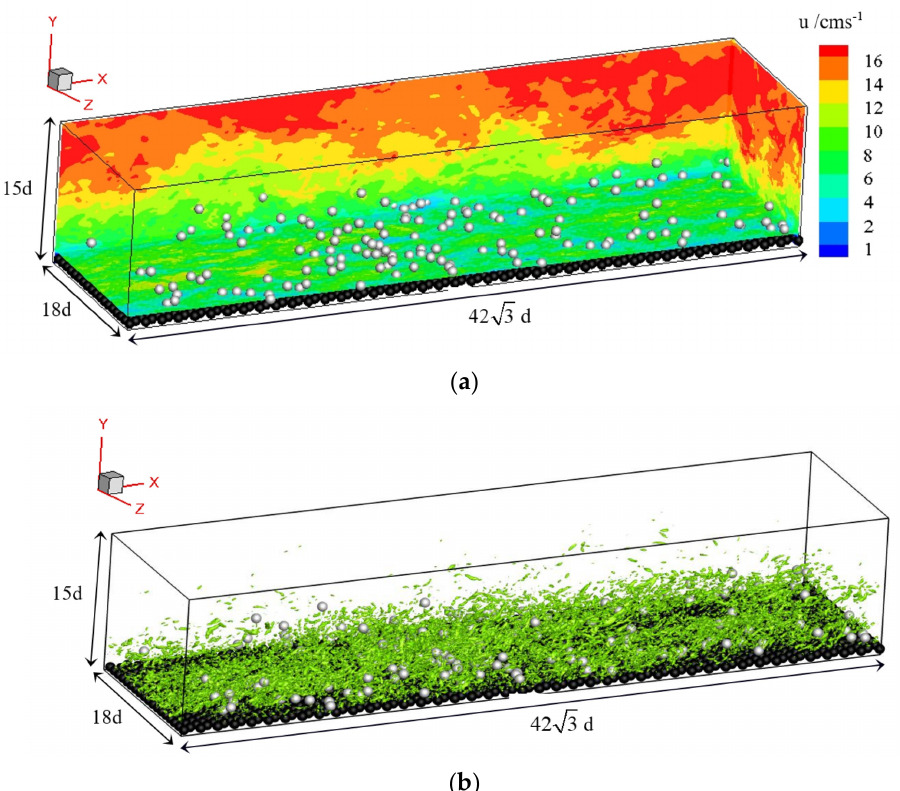
Figure 5. Instantaneous velocity and vorticity fields of the flow and particle distribution. The black particles are bed; the gray particles are the moving sediment particles. ( a ) Instantaneous contours of the streamwise velocity and the particle distribution. ( b ) Instantaneous vortical structures and the particle distribution. The blue iso-surface indicates the vortical structure, Q = 12,000 , which is the second invariant of the velocity gradient tensor.